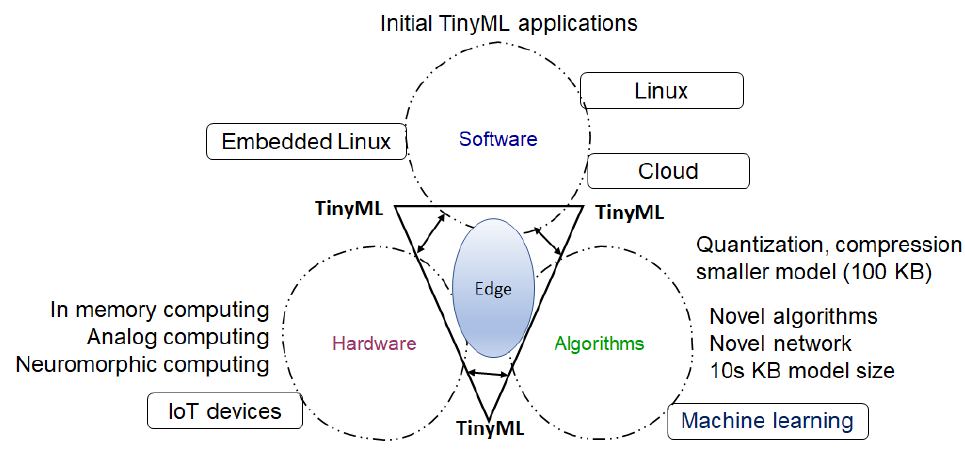
Figure 12. The composition of the TinyML paradigm (adopted from [161]).